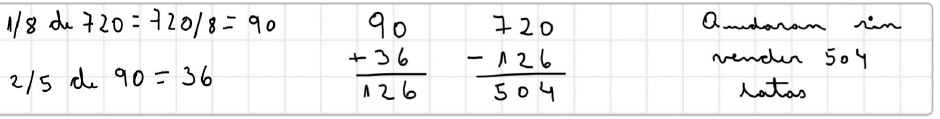
Figure 3. PT3’s written answer to problem FWP2. (Translation of PT3’s solution: “388 cans remain unsold.”).